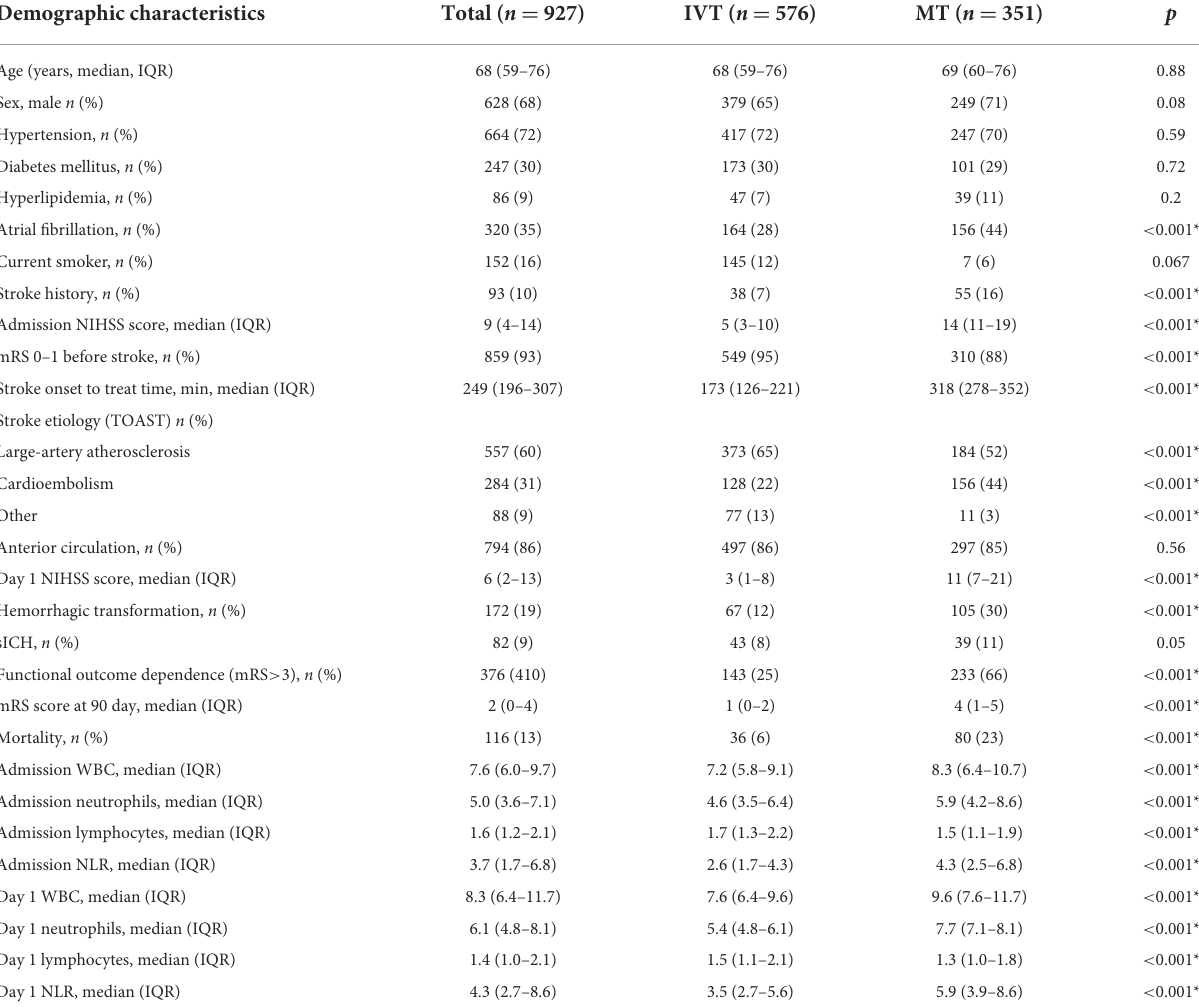
TABLE 1 Baseline characteristics of the study population and study